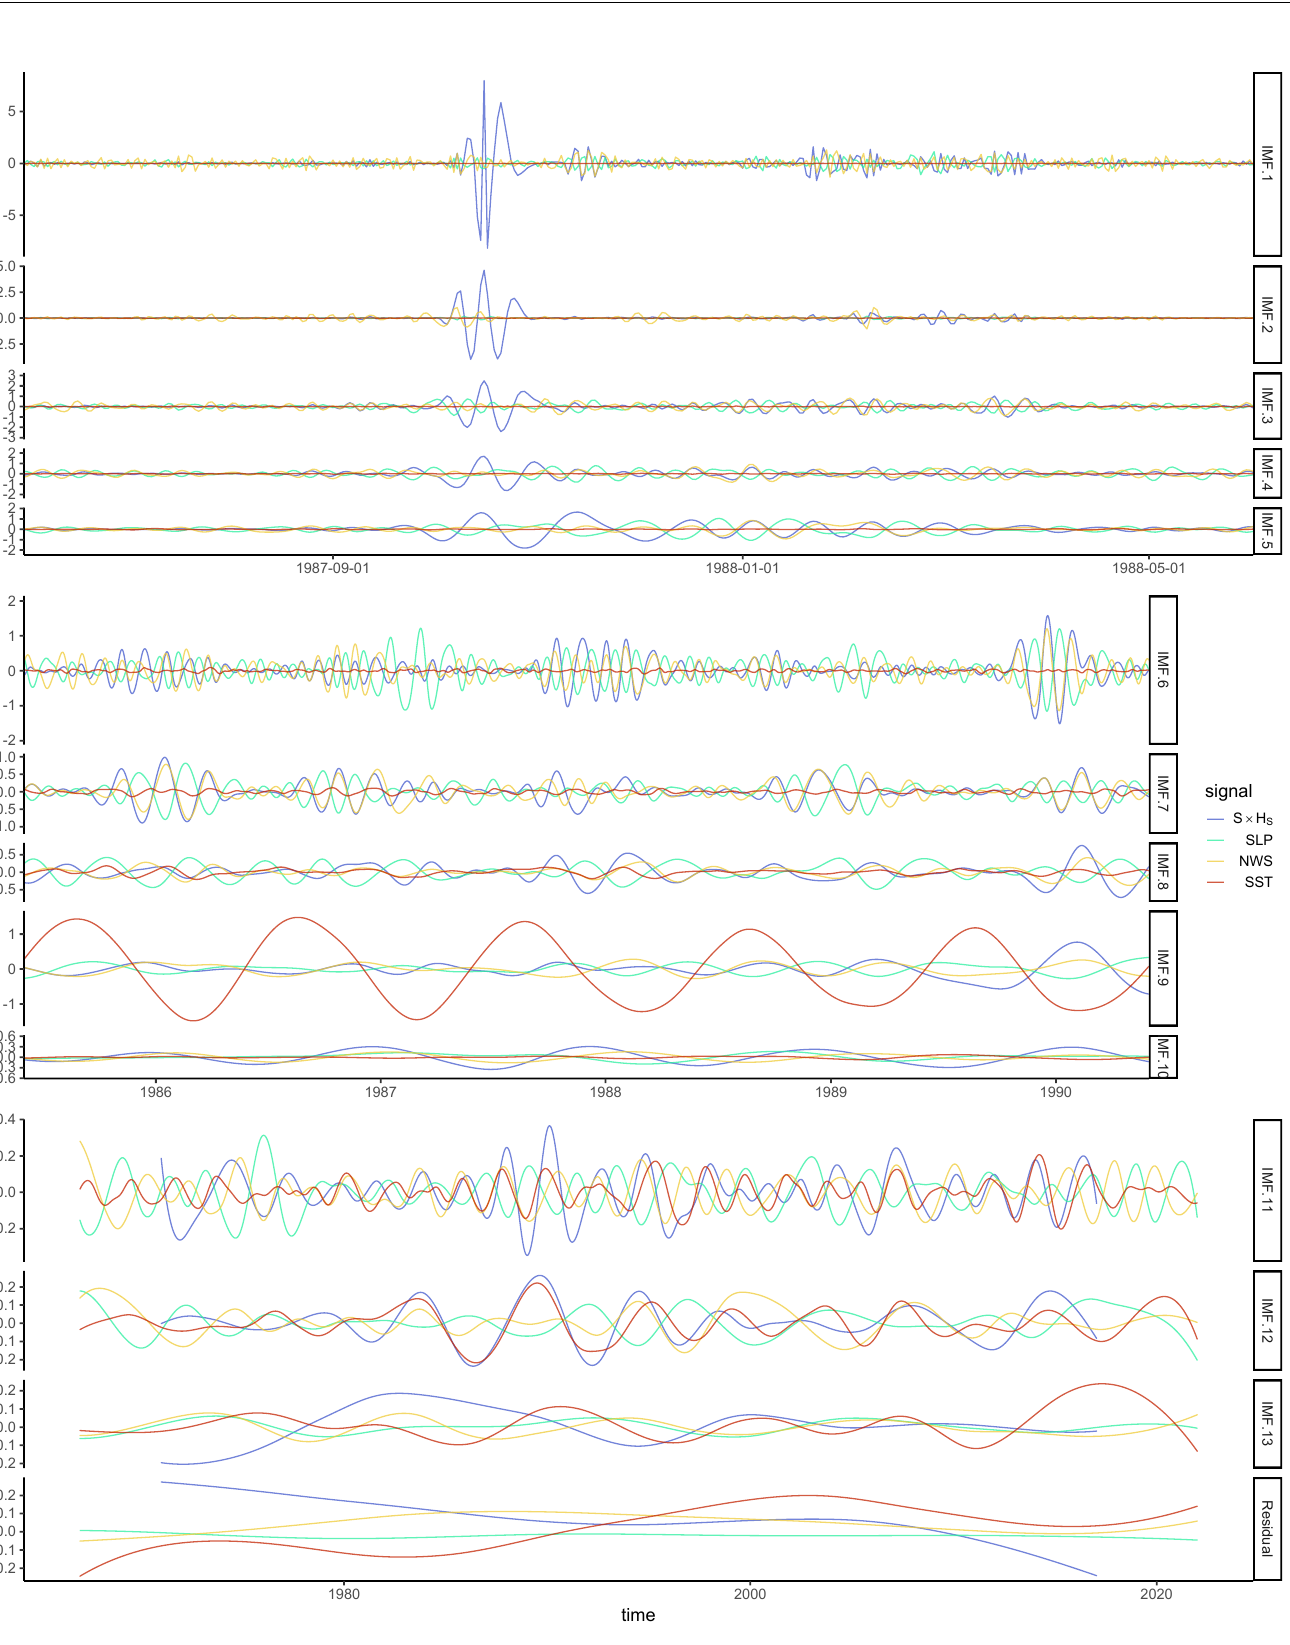
Figure 6. Similar to Figure 5 for S × H S . The maximal S × H S value of the analyzed period was on 16 October 1987 (the day of the maximal S